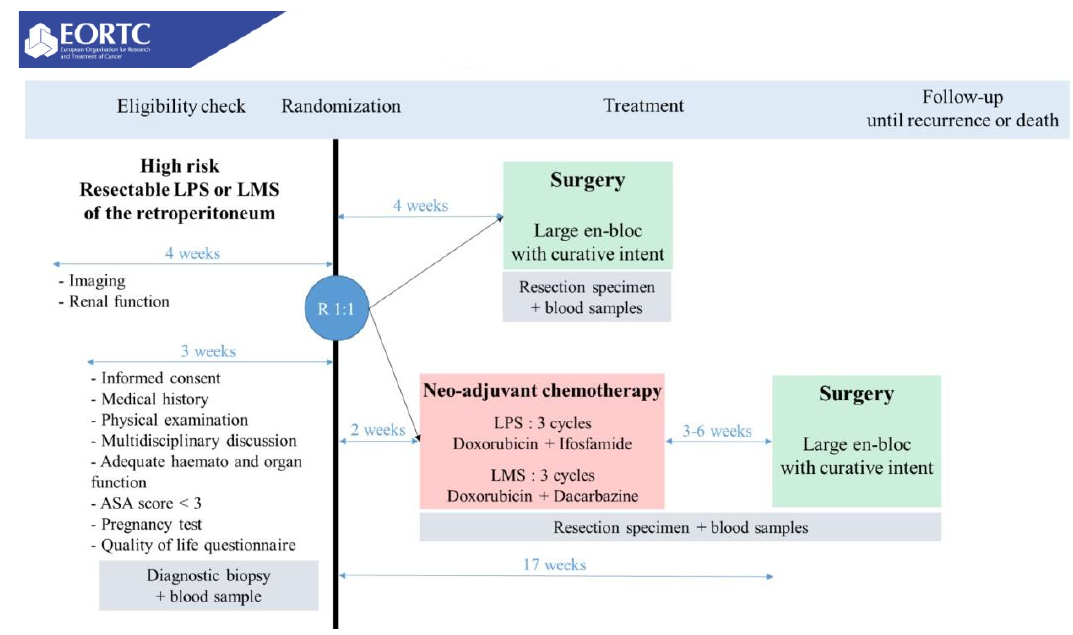
Figure 1. STRASS 2 study design,